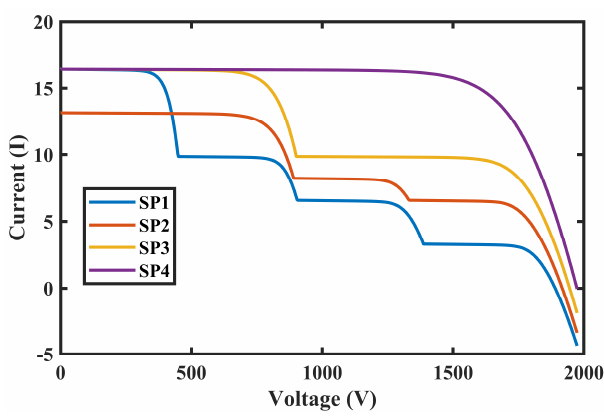
Figure 10. I ‐ V curves at different SPs.